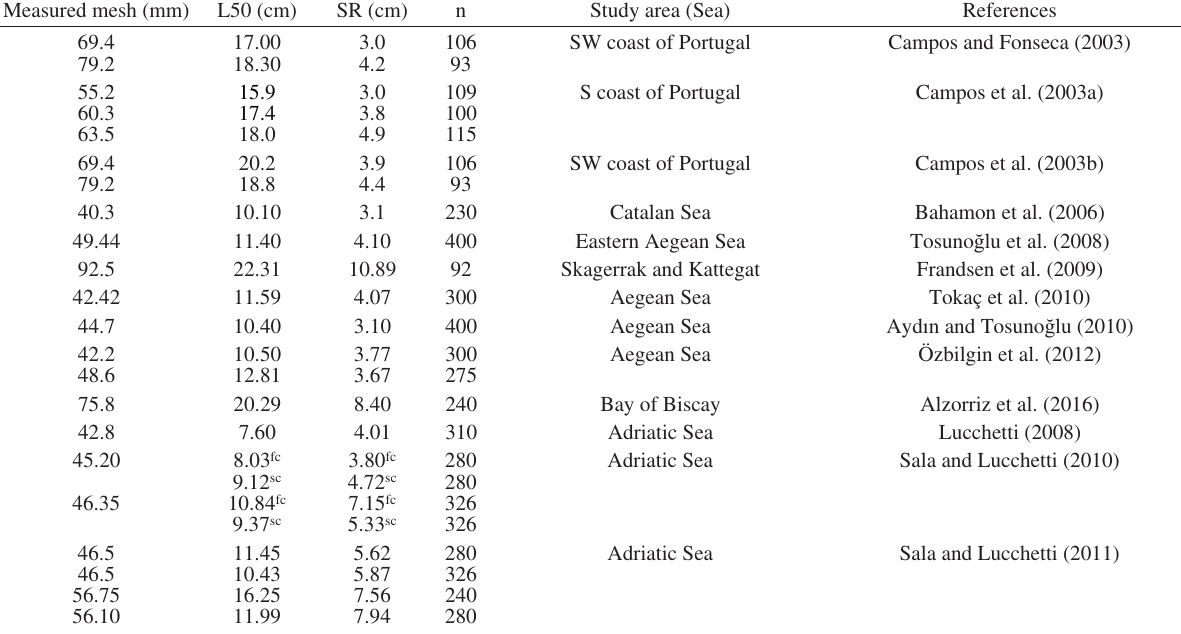
Table 1. – Experimental selectivity results for Hake in diamond mesh codends. n denotes number of open meshes in codend circumference. fc , first cruise; sc , second cruise. Measured mesh (mm)